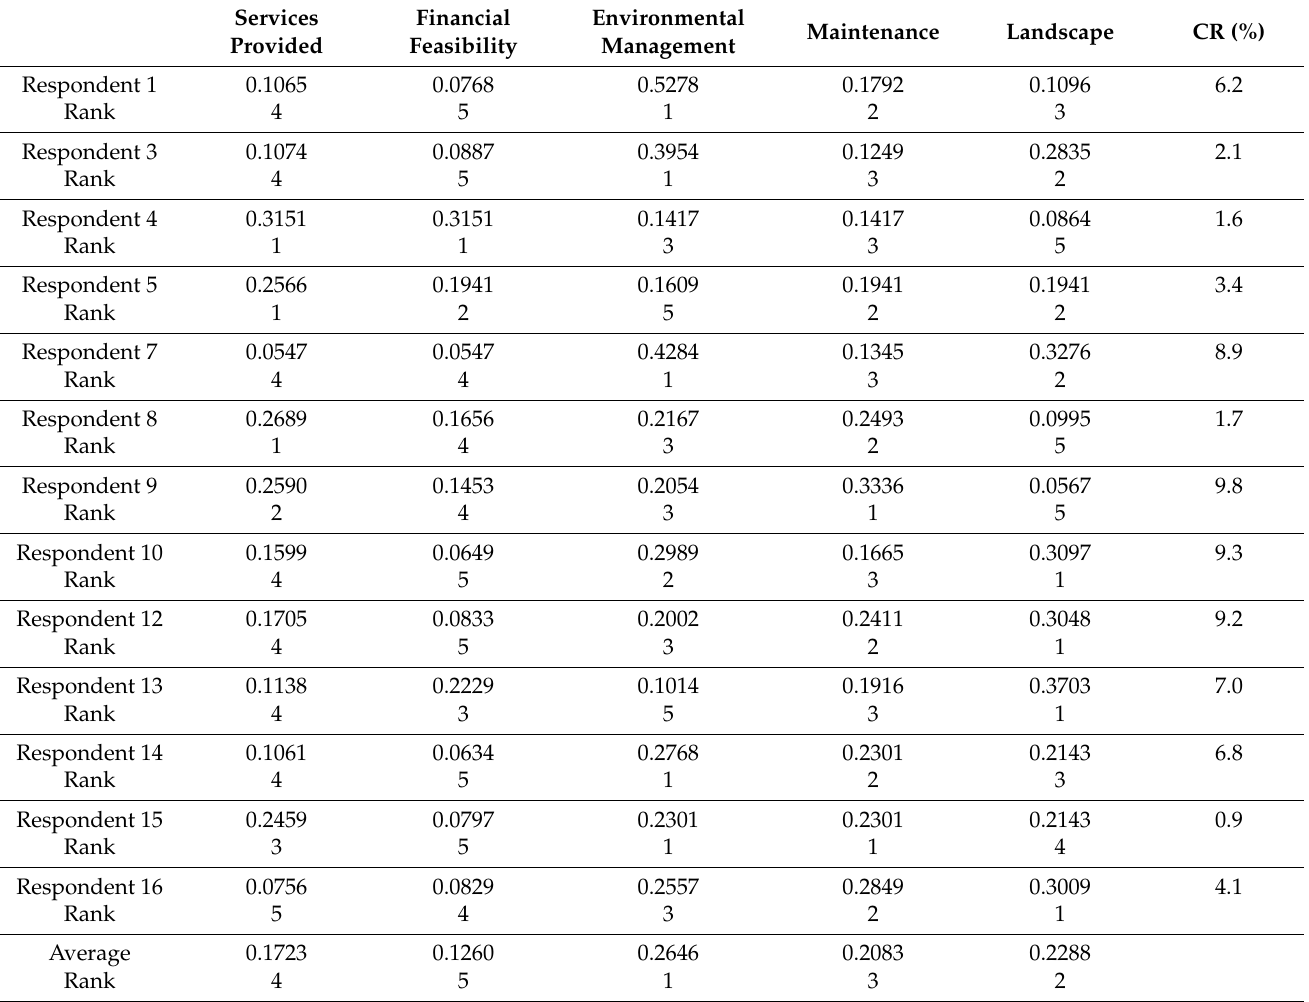
Table A1. Weighted coefficient related to the landscape and management activities.